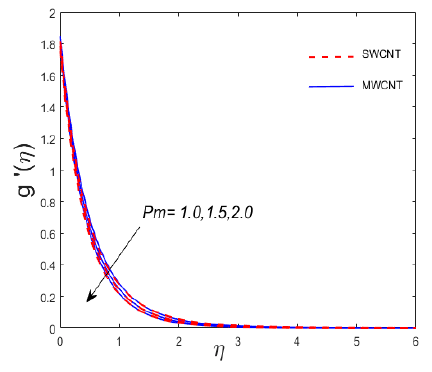
Figure 4. Outcome of Pm vs. 𝑓′(𝜂) .